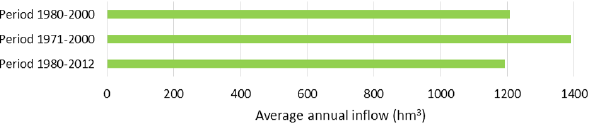
Figure 3. Average annual inflows observed in the Júcar River basin for different historical periods. Modified from Suárez-Almiñana et al.